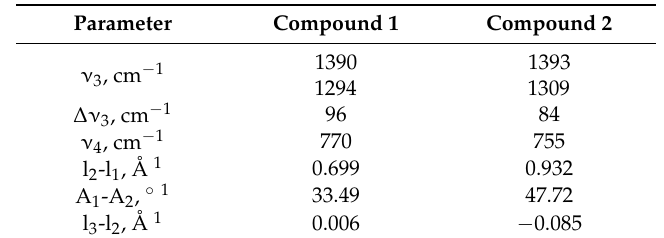
Table 1. Bands of nitrate asymmetric stretching ( ν 3 ) and in-plane bending ( ν 4 ) vibrations and geometric coordination mode